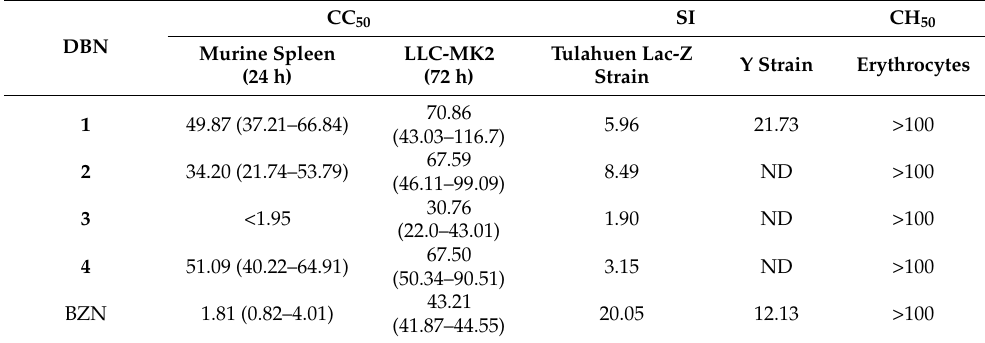
Table 2. In vitro cytotoxic (CC 50 ) and hemolytic (CH 50 ) activities of DBNs 1 – 4 , given in µ M. 95% confidence limits are given in